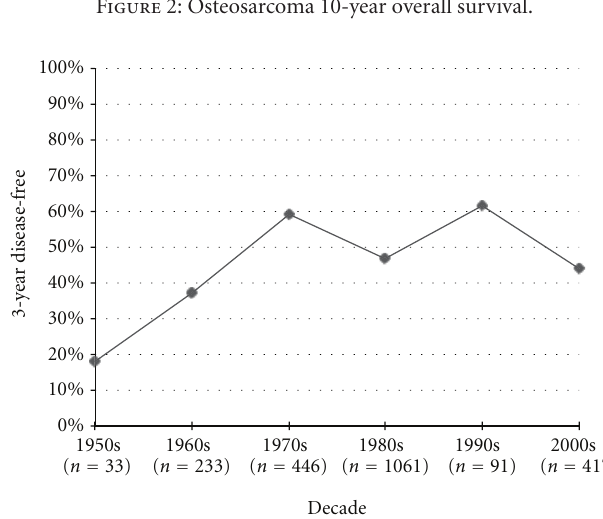
Figure 3: Osteosarcoma 3-year disease-free